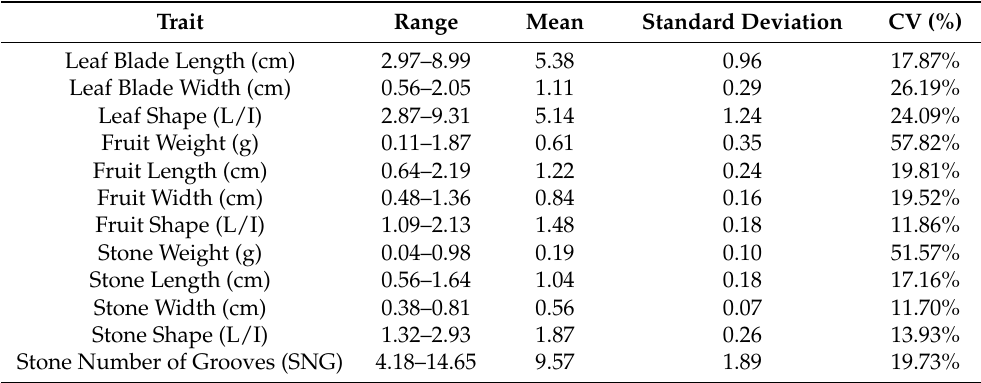
Table 2. Results for descriptive statistics obtained for the 175 samples based on the 12 analyzed quantitative traits.